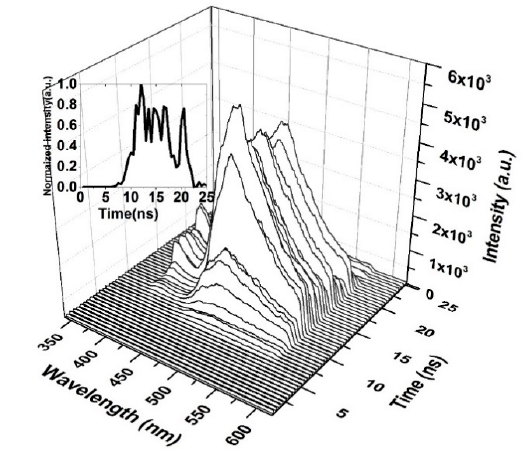
Figure 12. Time dynamics of CO thin-film LIF in chloroform at a pump energy of 0.55 mJ and a concentration of 15 mg/mL. The subfigure is the Z slice at 483 nm, which gives the intensity (a.u) vs time (ns) profile of the LIF peak at approximately 485 nm.